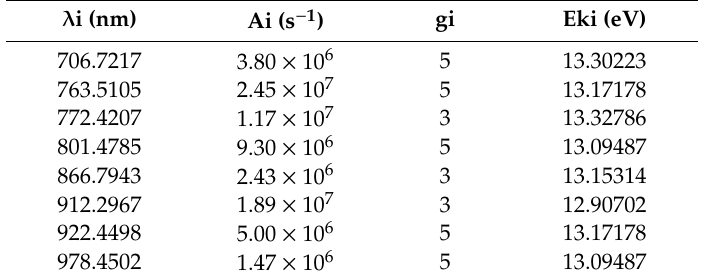
Table 2. Spectroscopic data of chosen lines for determination of electron temperature [23].